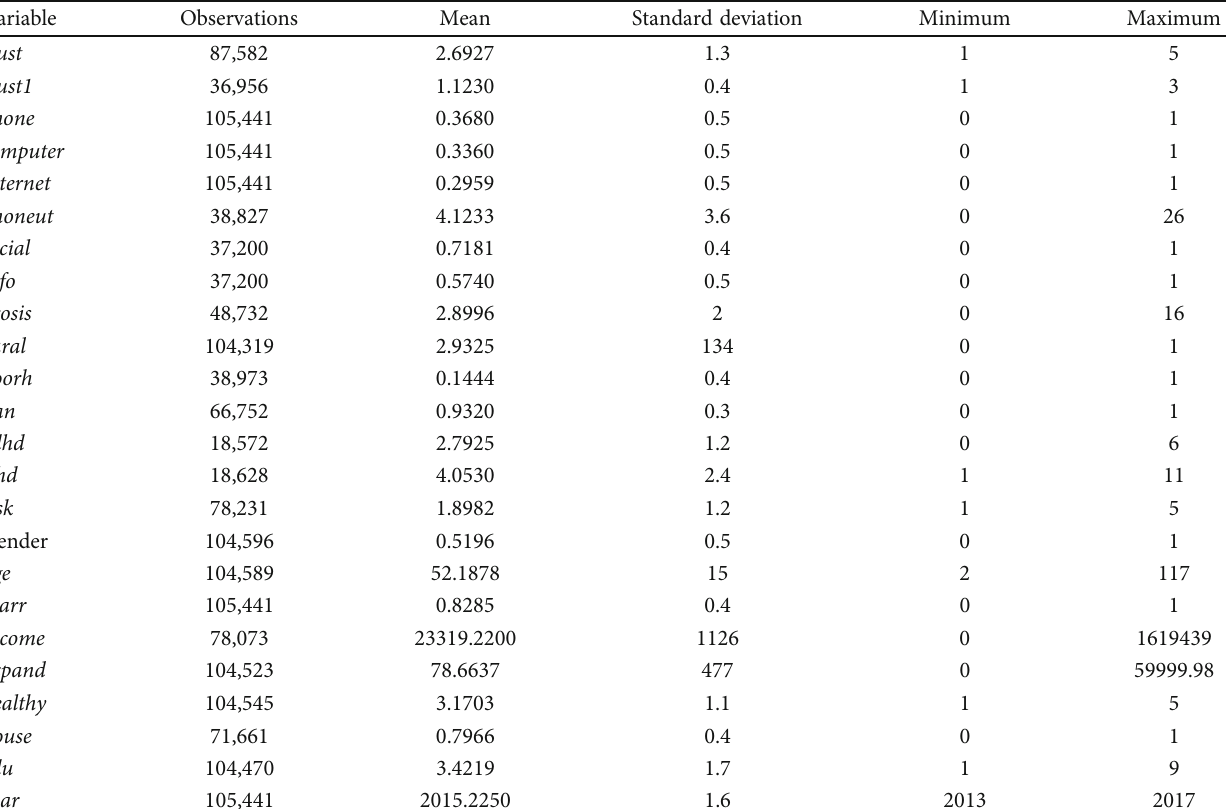
Table 2: Descriptive statistics.